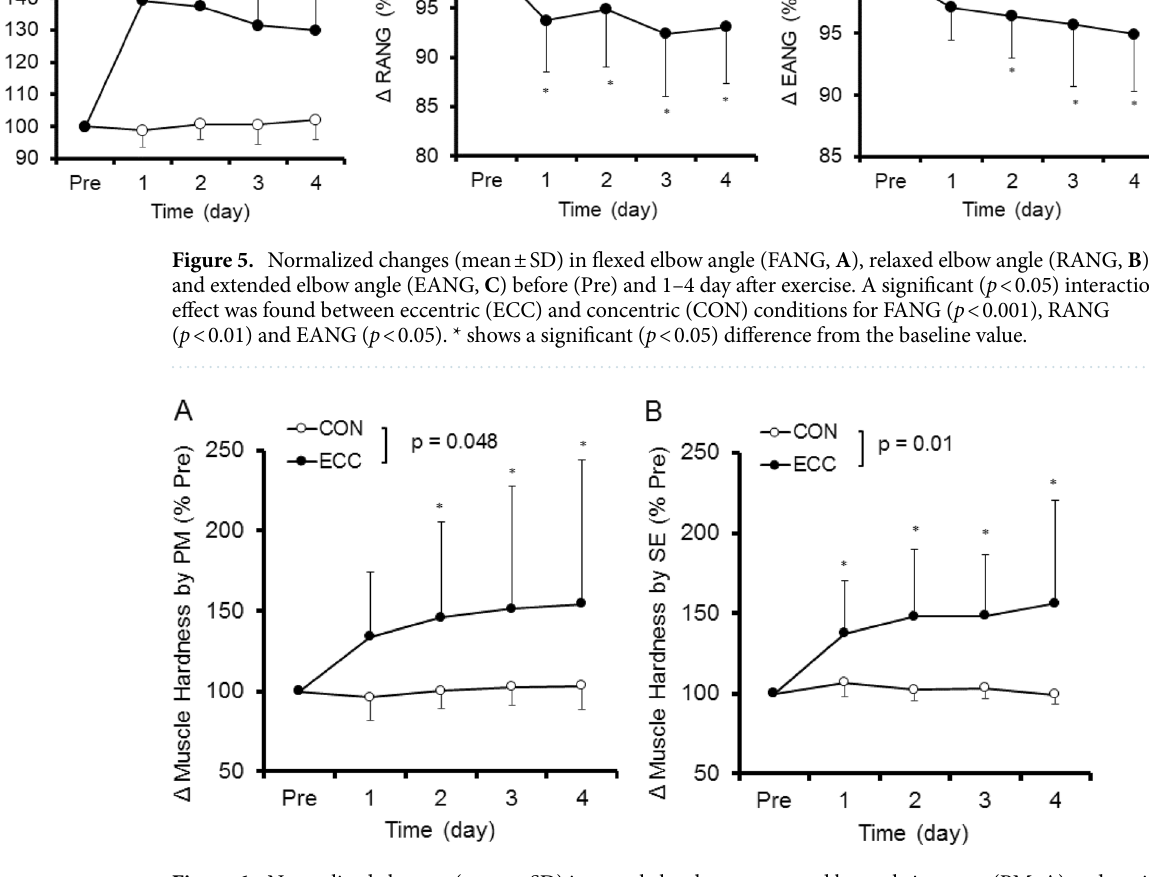
Figure 6. Normalized changes (mean ± SD) in muscle hardness measured by push-in meter (PM, A ) and strain elastography (SE, B ) before (Pre) and 1–4 day after exercise. A significant interaction effect was found between eccentric (ECC) and concentric (CON) conditions for changes in PM ( p < 0.05) and USE ( p < 0.01). * shows a significant (p < 0.05) difference from the baseline